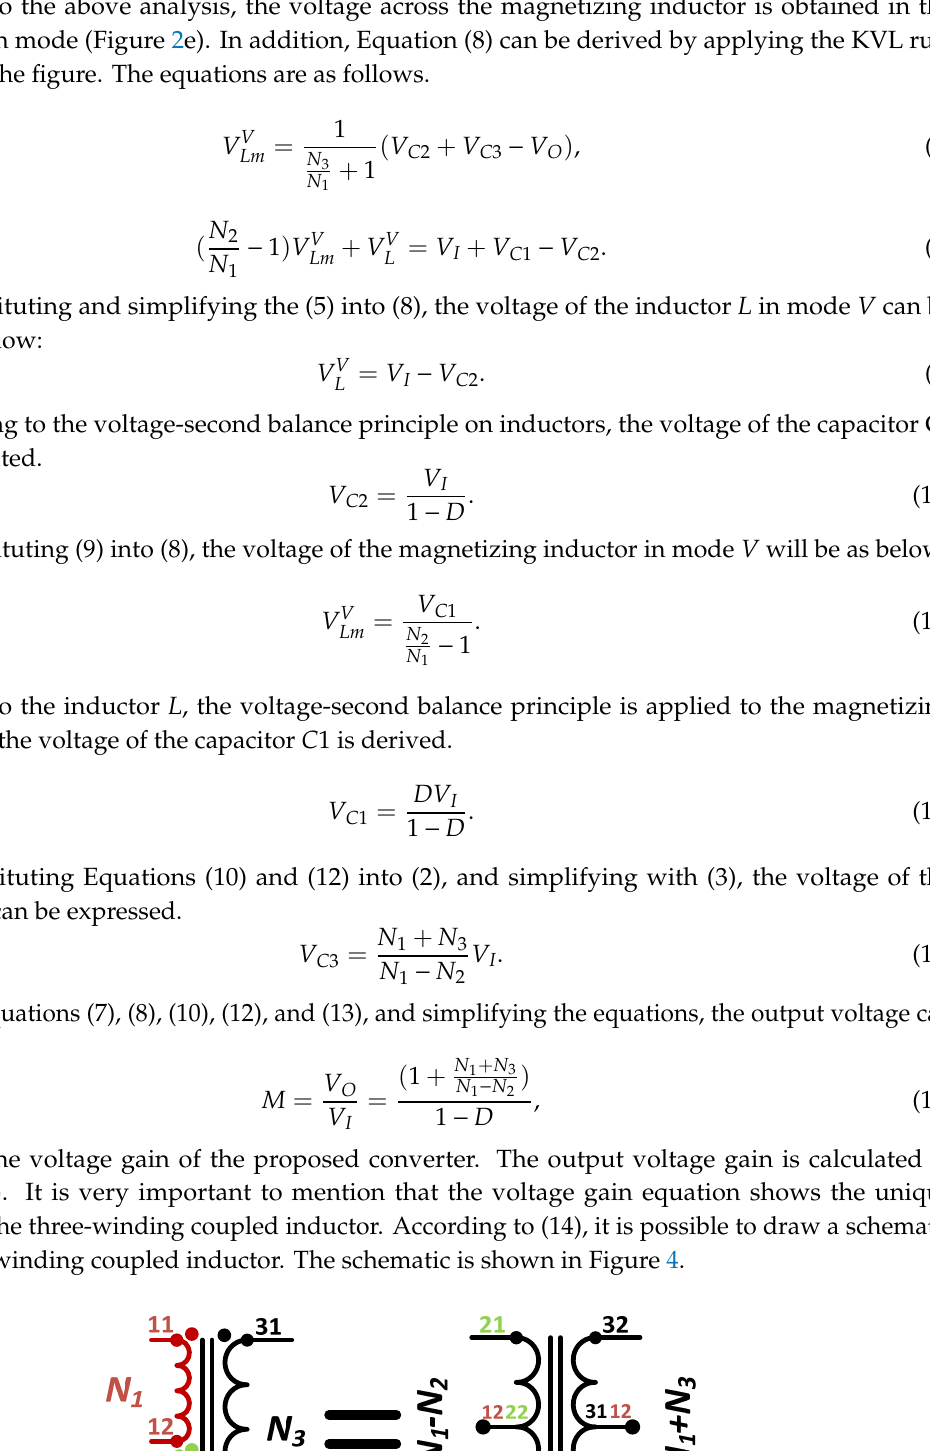
Figure 5. The voltage gain of the presented converter versus duty cycle. 3. Converter Design Considerations In this section, the presented converter is analyzed so that the design criteria could be derived. This section focuses on the optimum design and selection of the capacitors, inductors, diodes, and the power switch in order to achieve an acceptable performance. First, the minimum values of the inductors must be calculated so that the presented converter operates in Continuous Conduction Mode (CCM). The Discontinuous Conduction Mode (DCM) must be prevented since it has various drawbacks such as the dependency of the output voltage on the frequency and the load, slow dynamic response. In [23] and [24], it is discussed the average current of an inductor must be more than half of its current ripple for CCM [3]. The current ripple of the inductors L and the average current of the inductor L can be written according to Figure 3.